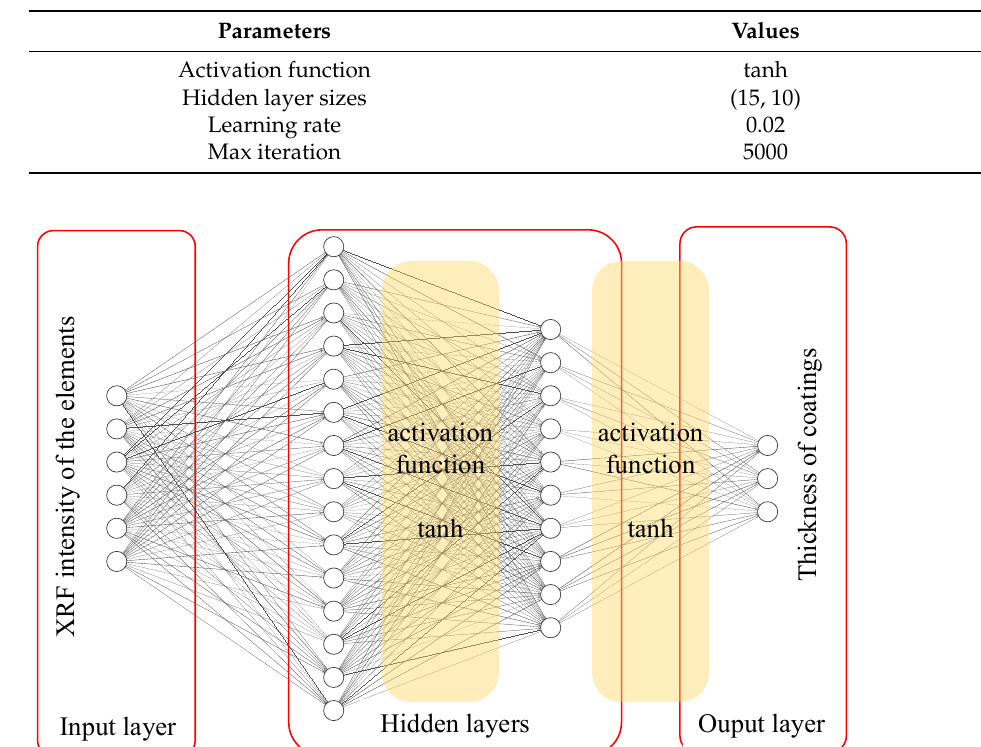
Table 3. BPNN parameter settings.